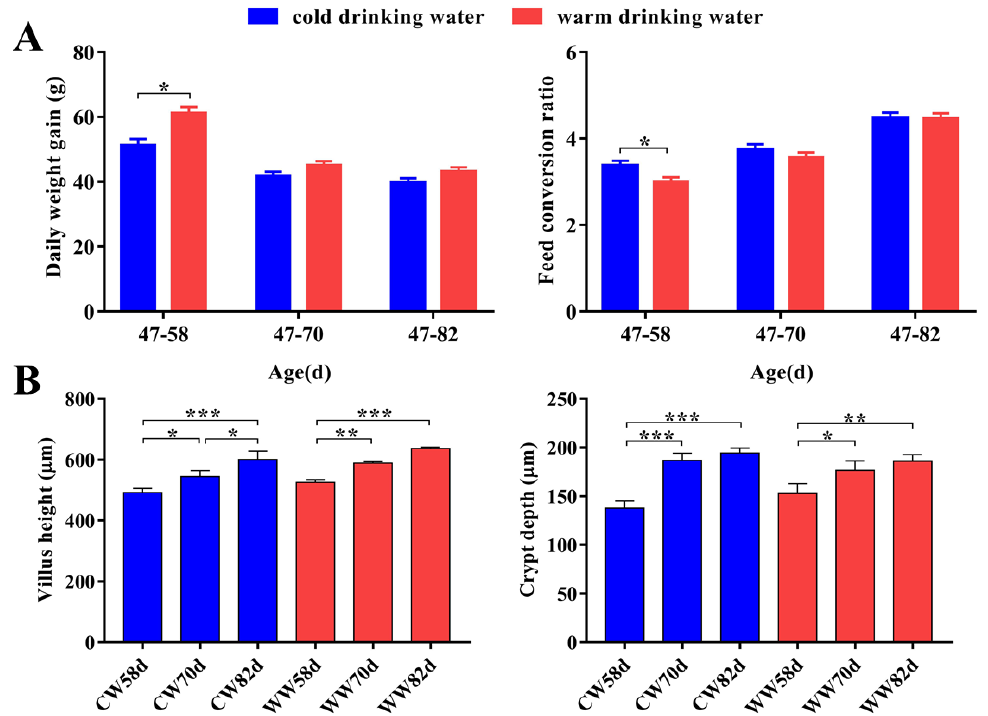
Figure 1. Effects of drinking warm water on the production performance and intestinal mucosal morphology of rabbits. CW, cold water group; WW, warm water group. ( A ) Average daily weight gain and feed conversion ratio ( n = 15). ( B ) The villus height and crypt depth in the jejunum ( n = 4–8). * p < 0.05, ** p < 0.01, *** p < 0.001. Values are shown as means ± SEM. Differences were analyzed by one-way analysis of variance followed by the least-significant di ff erence post hoc